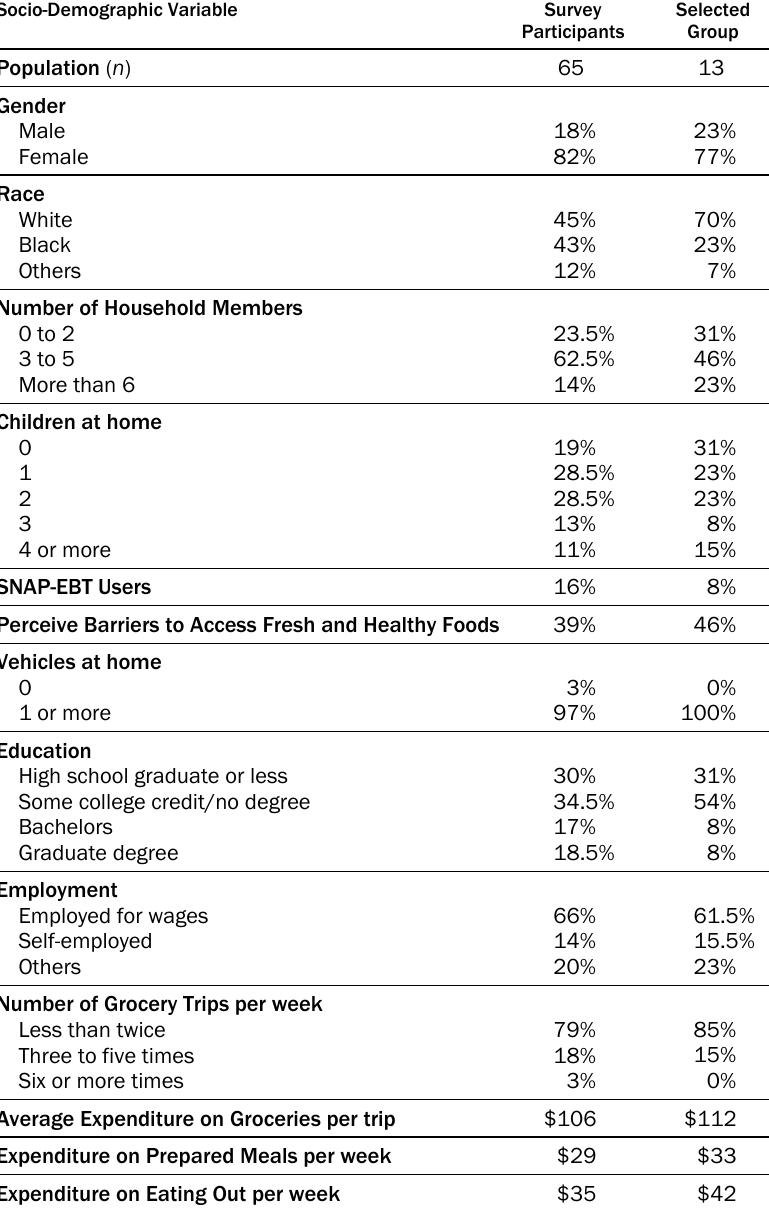
Table 1. Interviewees’ Socio-demographic Data and Expenditures on Groceries, Prepared Meals, and Eating Out Some figures have been